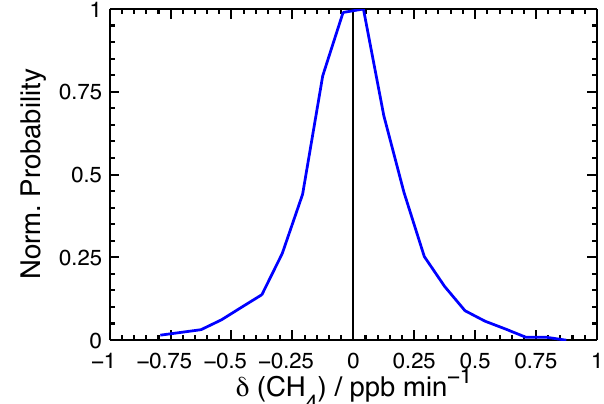
Fig. 8. PDF of the instrumental drift during airborne operation in- ferred from calibration to CH 4 flask-sample measurements. The standard deviation ( 1 σ ) is 0.24 ppb/min.